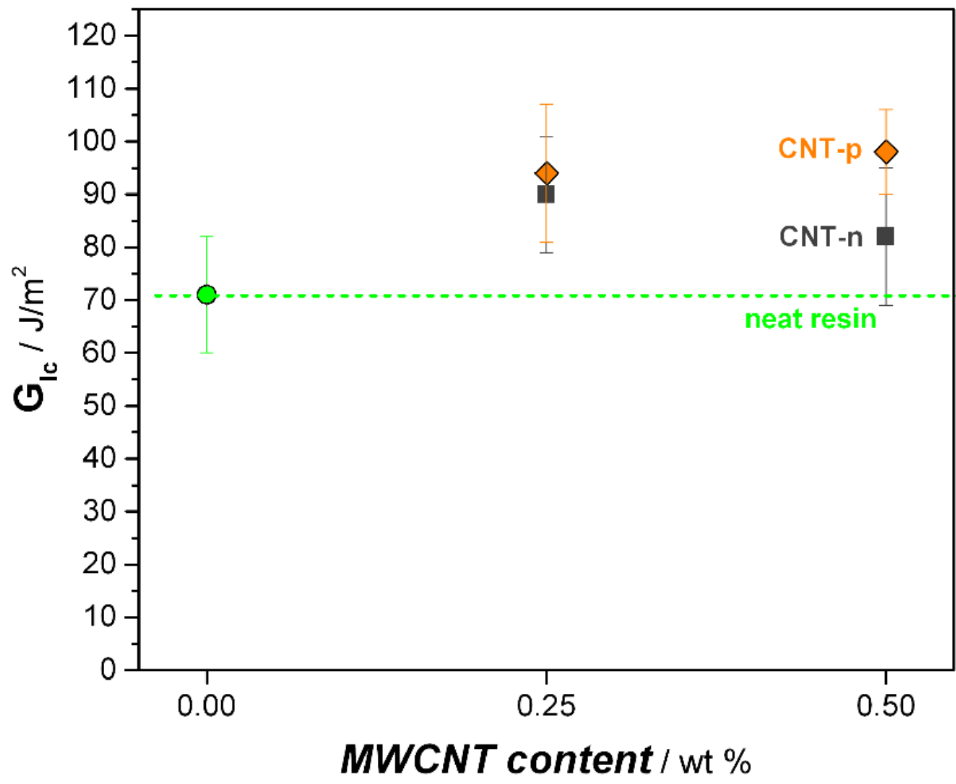
Figure 6. Strain energy release rates of neat and MWCNT-modified nanocomposites.